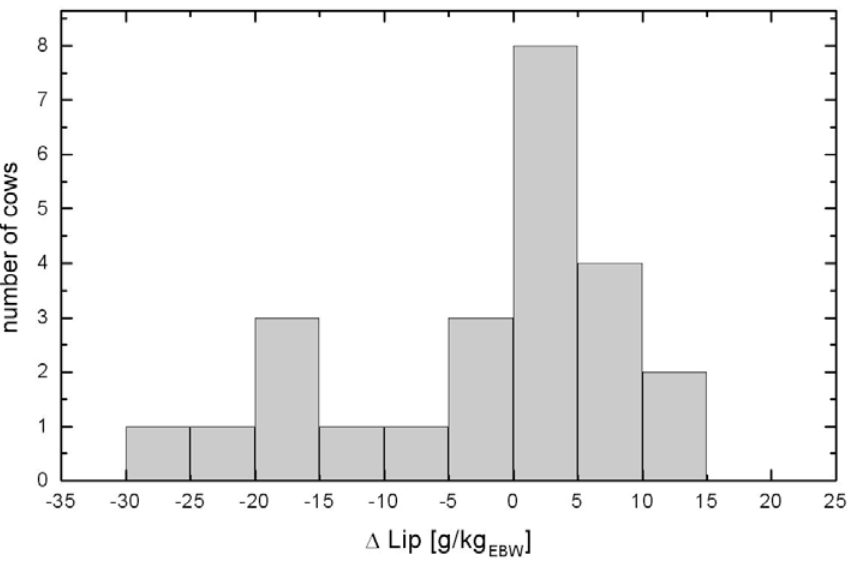
Figure 4 Distribution of differences ΔLip=Lip2−Lip2 (Lip2: lipids level at second sampling, Lip1: lipids level at first sampling) in grams for 1 kg of empty body weight